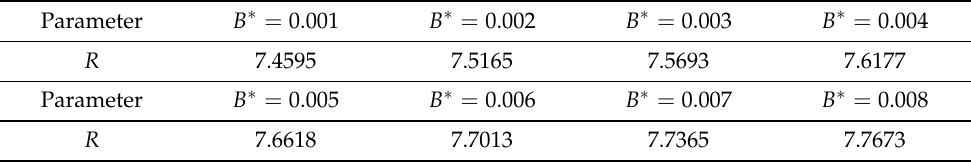
Figure 1. Effective potentials for different uniform magnetic field parameters B ∗ . The other parame- √ ters are L = 2 3, a = 0.1, and Q ∗ = 0.0002. Table 1. Radii R of stable circular orbits in Figure 1.